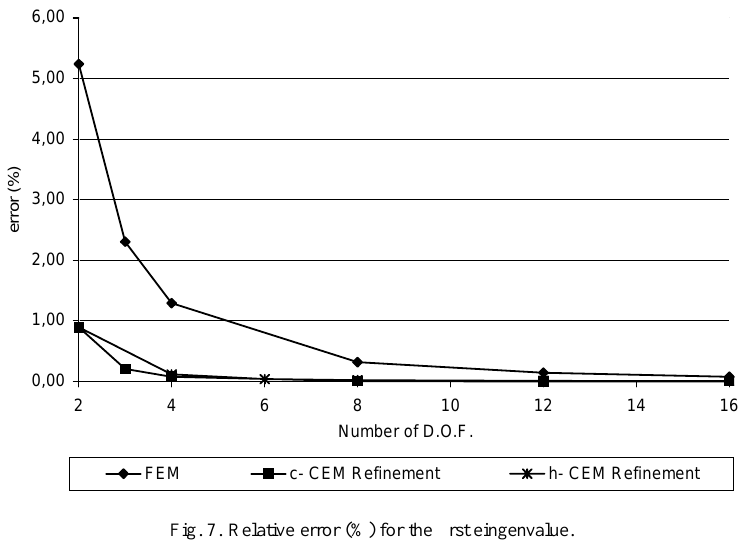
Fig. 7. Relative error (%) for the first eingenvalue.